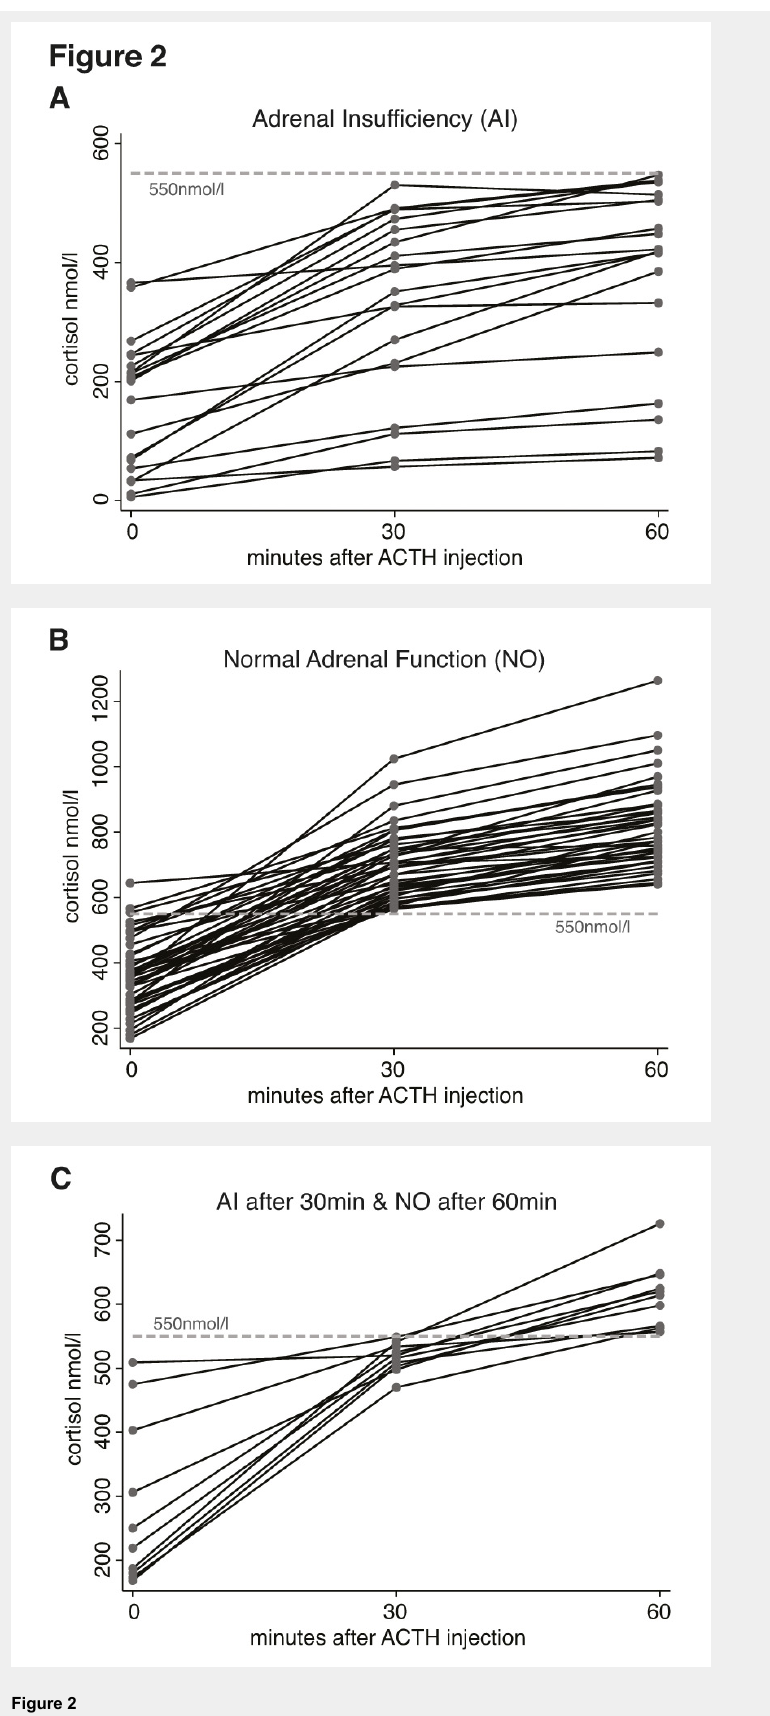
Figure 2 Individual cortisol values at time points 0, 30, and 60 minutes after injection of ACTH; grouped by patients with adrenal insufficiency (fig. 2a), normal adrenal function (fig. 2b) and patients with discrepant adrenal response at 30 and 60 minutes (fig.